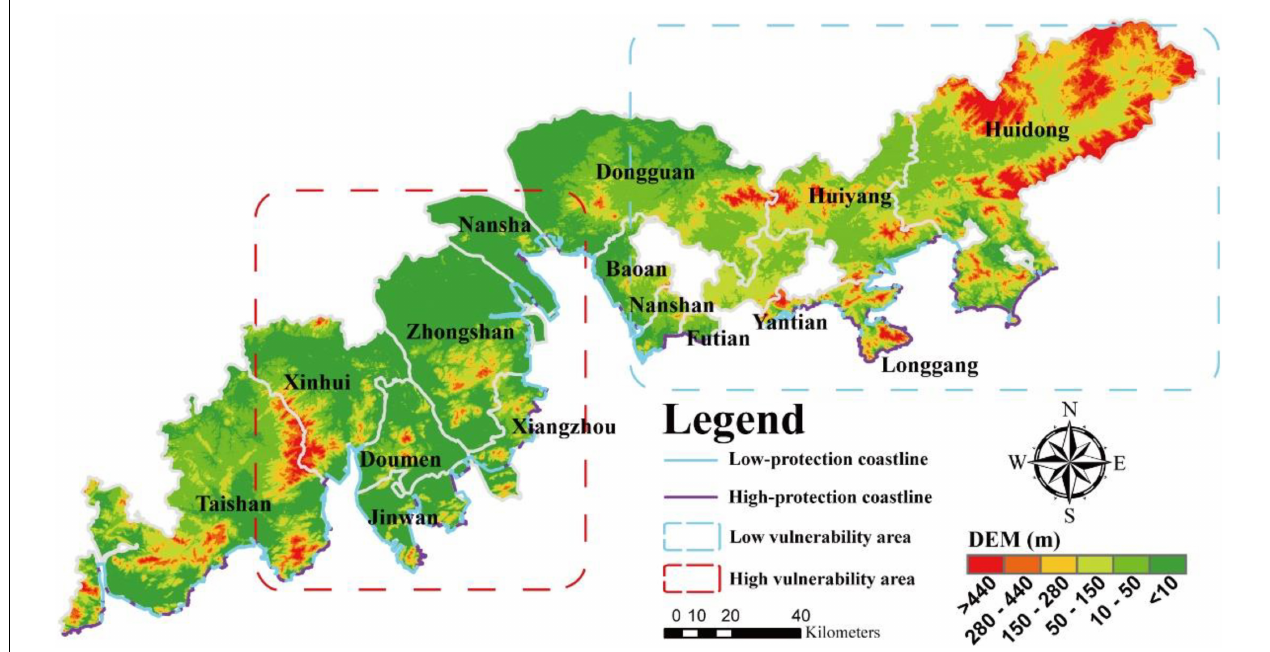
FIGURE 8 | Distribution map of coastal characteristics differences in the study area. Coastal characteristics include coastal lowlands and protection capability, which are reflected in DEM and protection coastline in the